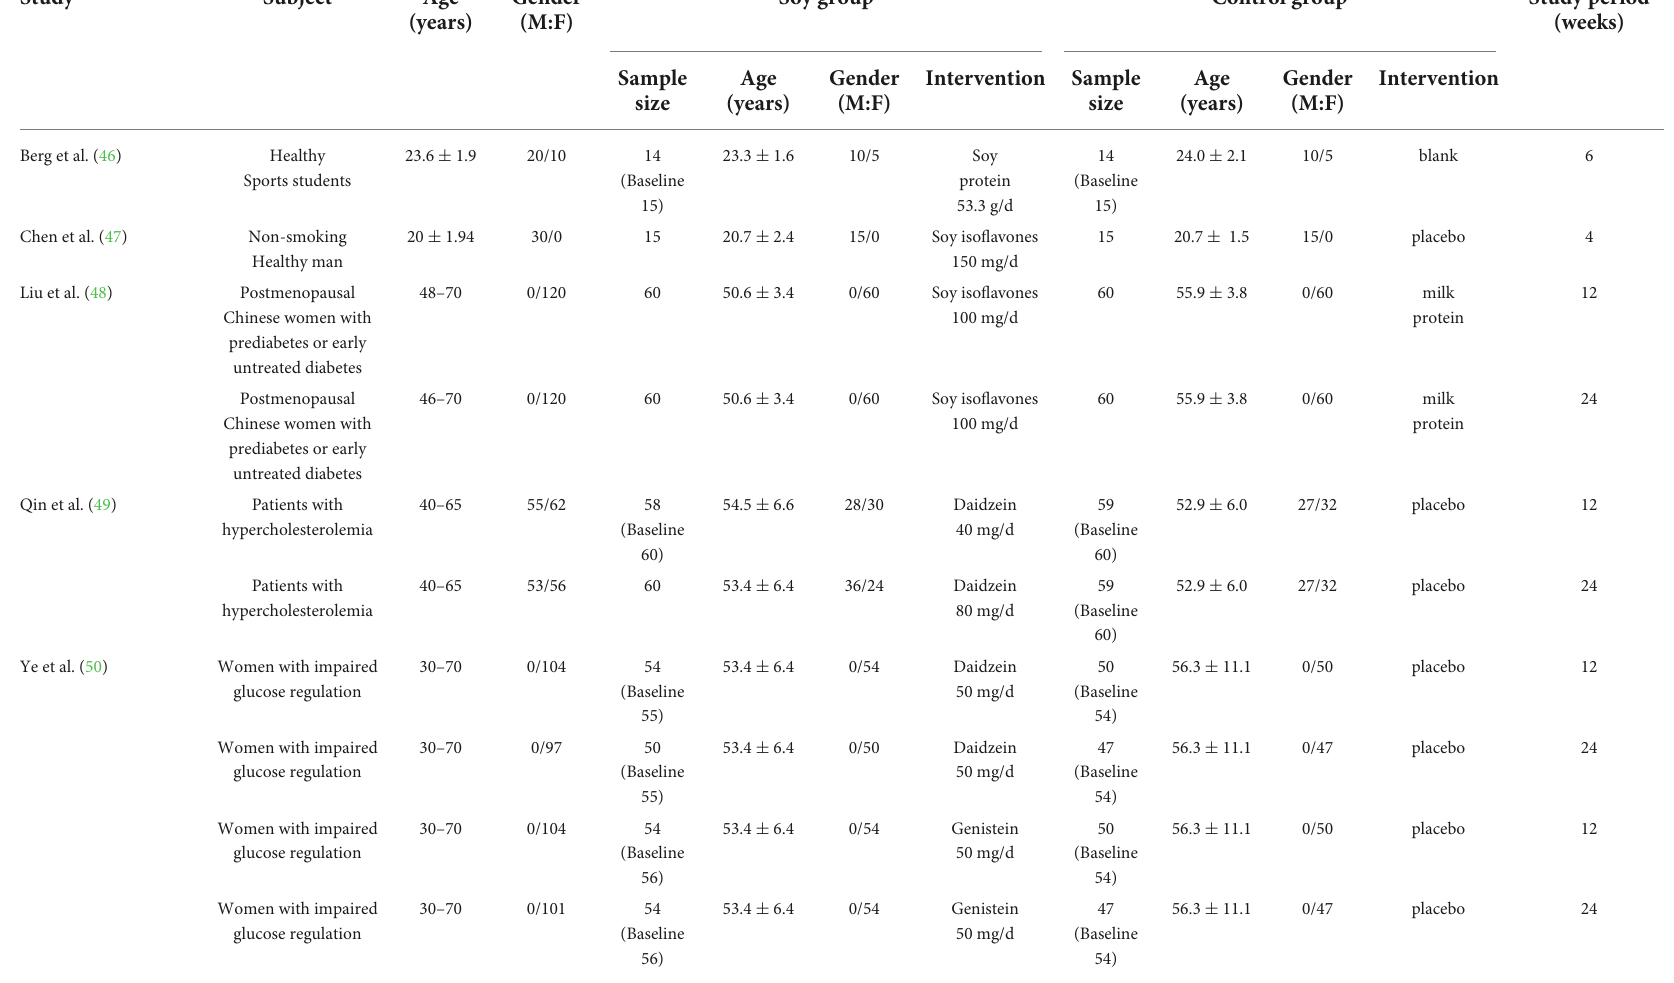
TABLE 2 Characteristics of long-term human clinical